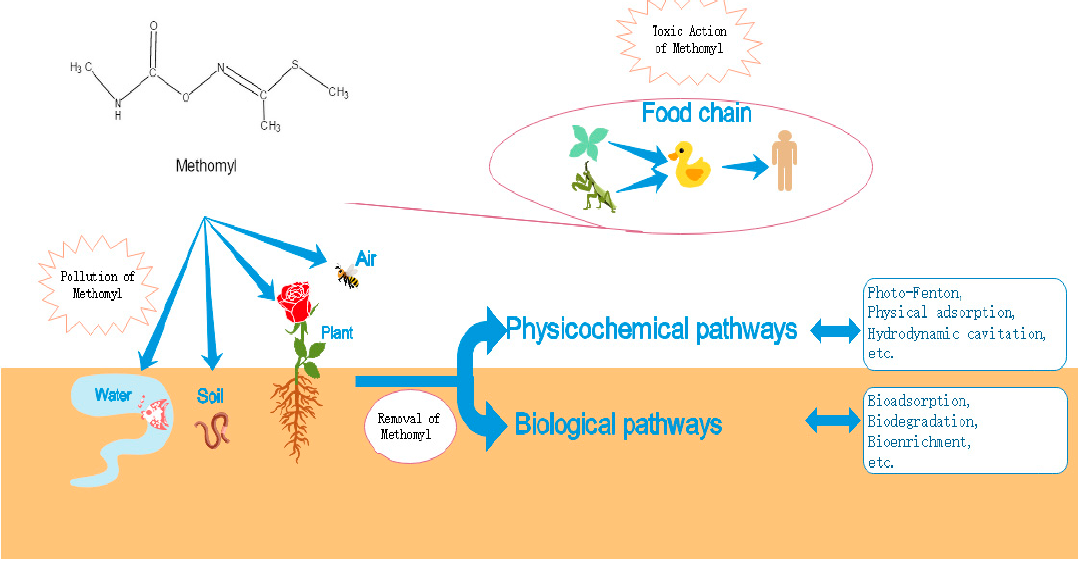
Figure 2. Contamination and removal of methomyl from soil environments.